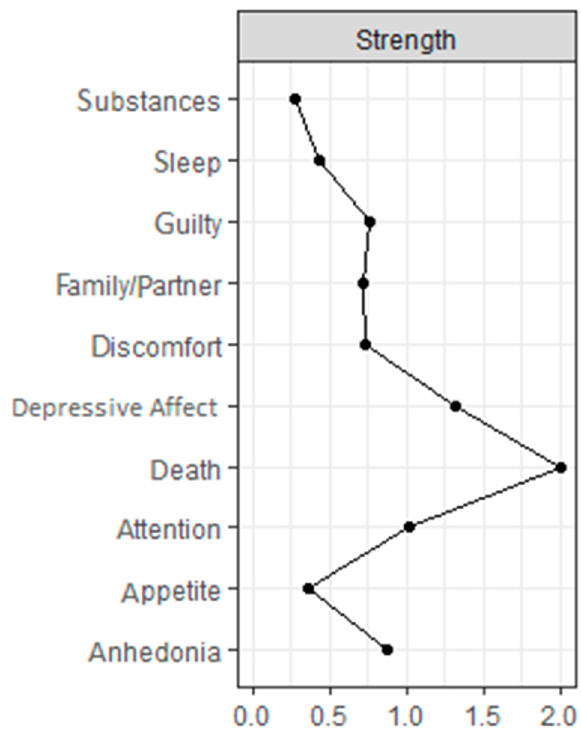
Figure A5. Centrality measures for the DCET factors for the moment ‘always’ (z-scores). Note —In this case, the force indices are also presented, since, as there are some negative relationships between the nodes, they are not equal to those of expected influence, as is the case for the other time moments.